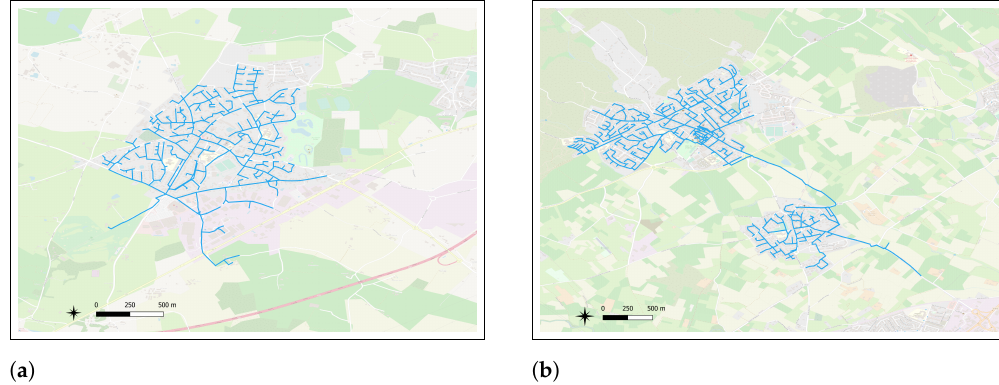
Figure 3. Use case graphs. ( a ) A sub-graph of the Angers metropolis wastewater network and ( b ) a sub-graph of the Montpellier metropolis wastewater